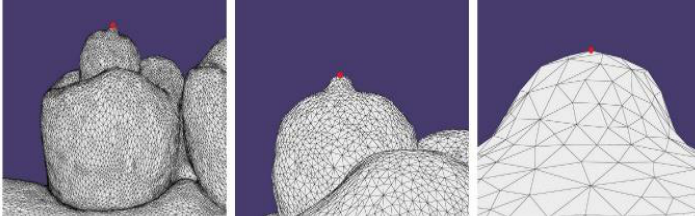
Figure 2. Reference point with increasing magnification .